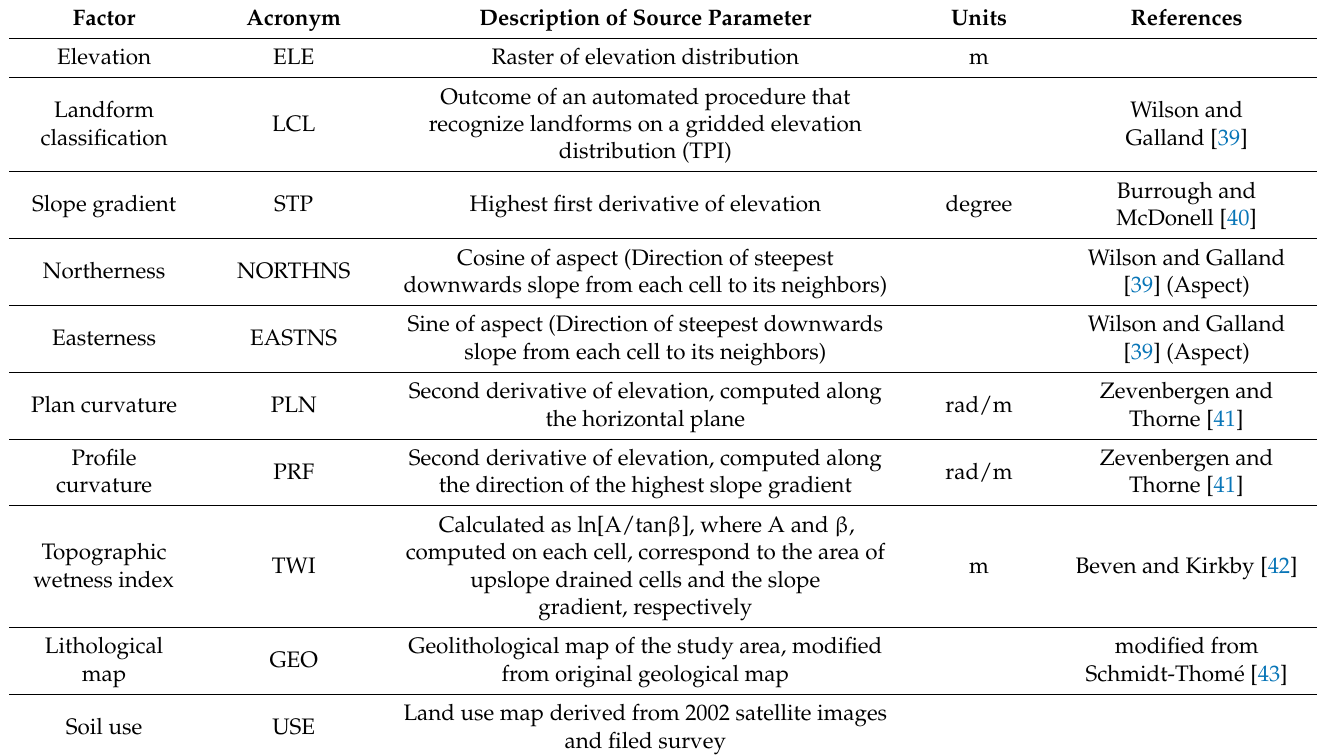
Table 1. Details of the selected geo-environmental